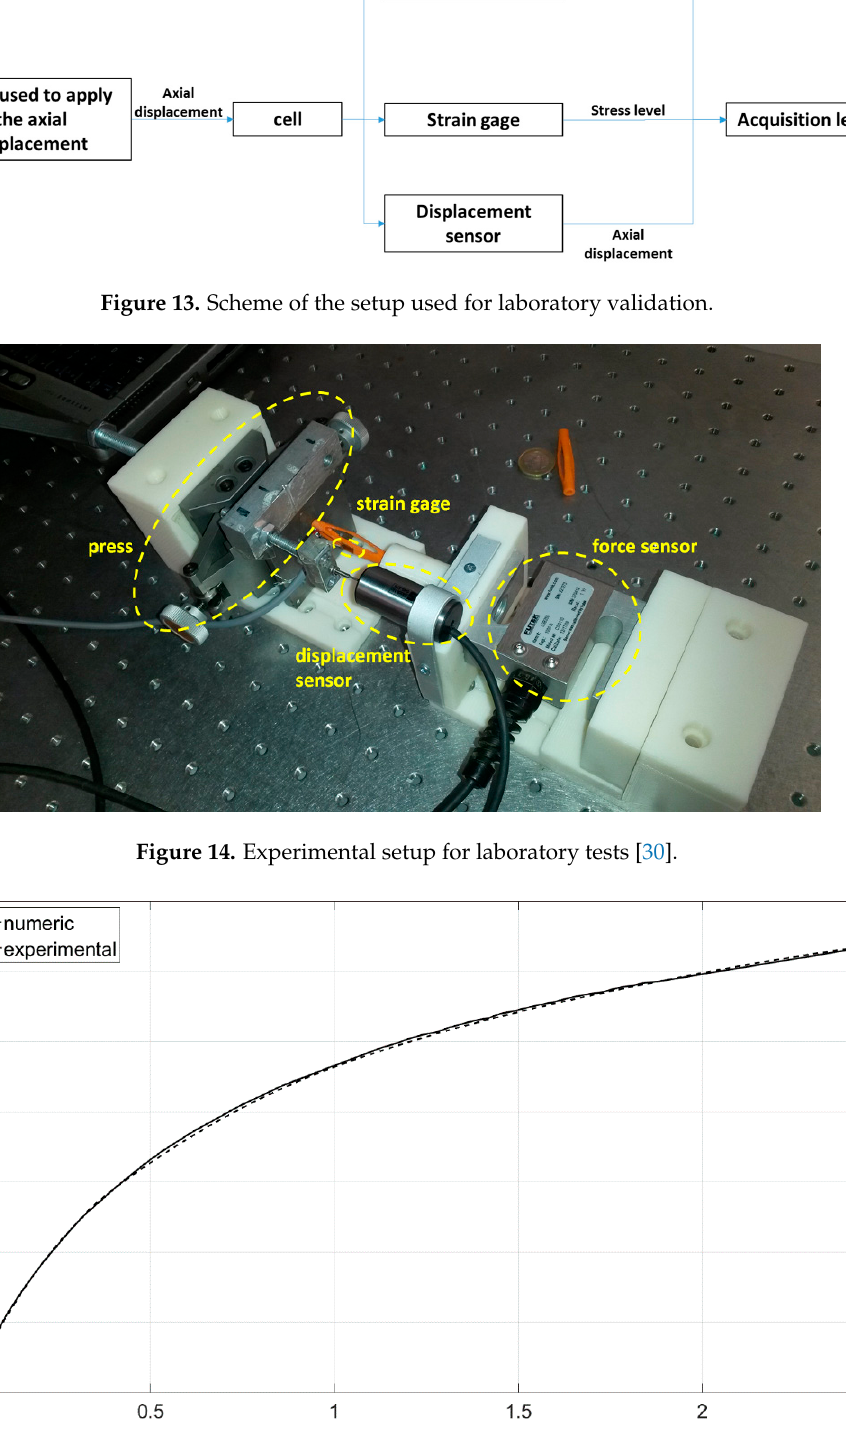
Figure 15. Axial load vs strain on the arms, numerical vs experimental results [30].